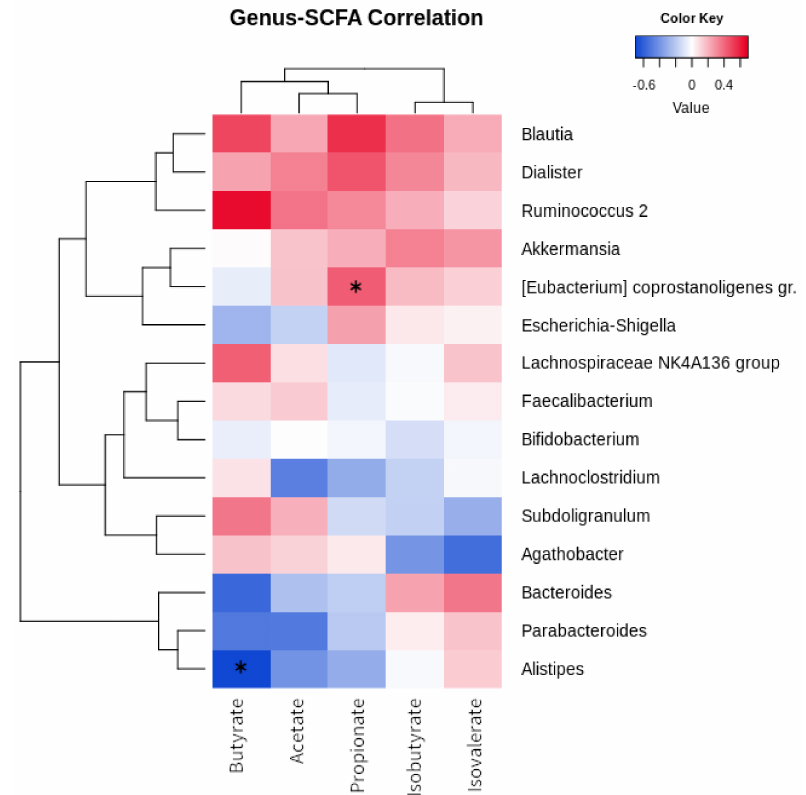
Figure 3. Correlation of bacterial genera and SCFA. Heatmap showing the Euclidean correlation R-values occurring between the most abundant bacterial genera and fecal SCFAs. Clustering was performed through a complete agglomeration method. Asterisk indicates significant ( p < 0.05) correlation (asymptotic p -value).